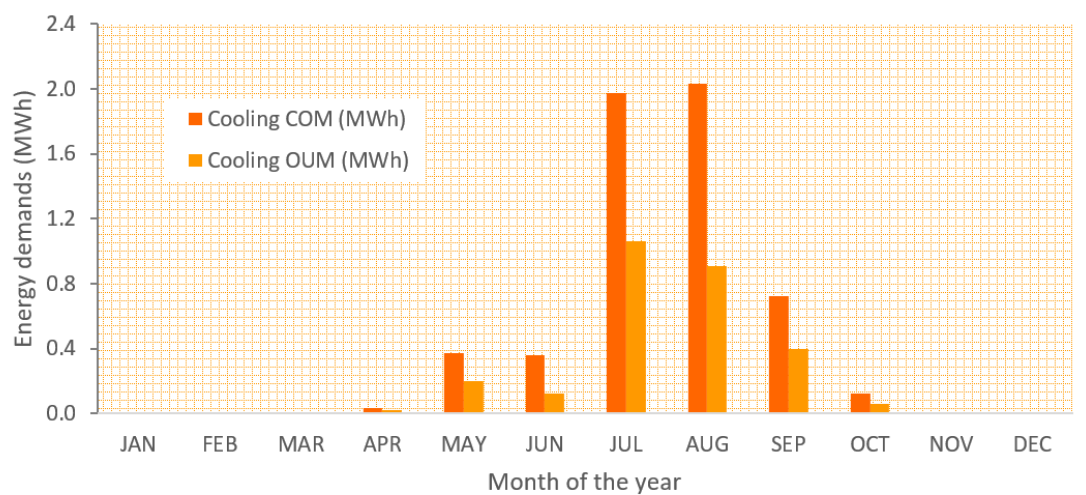
Figure 16. Monthly heating energy demand of the surgical suite during current operation mode (COM) and off-use operation mode (OUM).